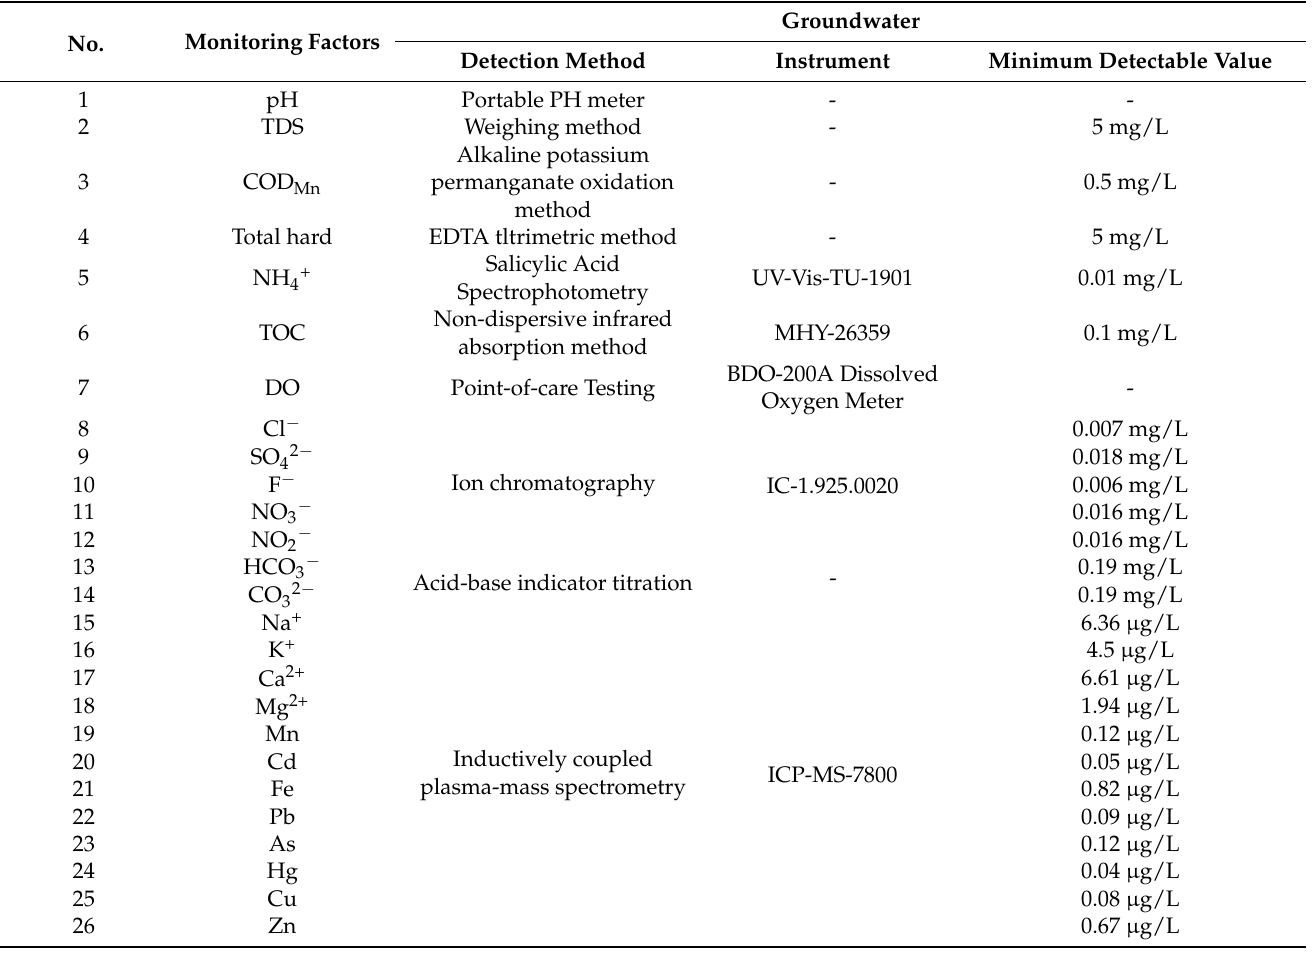
Table 1. Analytical methods and minimum detection